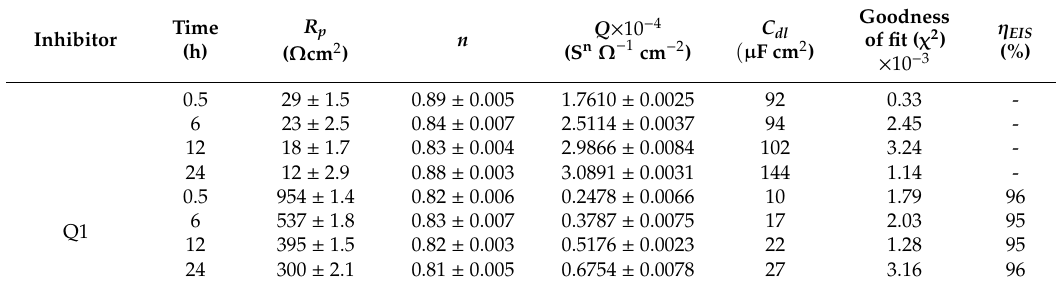
Table 3. Effect of immersion time on polarization resistance and inhibition efficiency of MS in the absence and presence of Q1.